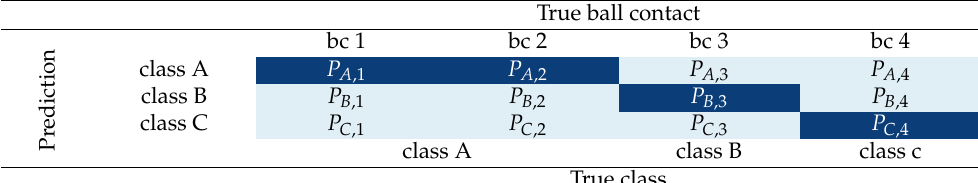
Table 8. Example of our adaptation of the normalized confusion matrix to show classification performance for detailed ball contact labels (bcs). P c , b denotes predictions of class c of instances of the true ball contact b . For orientation, we give the true class on the bottom. Light color represents low values, dark color represents high values. For an optimal classifier P A ,1 , P A ,2 , P B ,3 and P C ,4 are one and all other cells contain